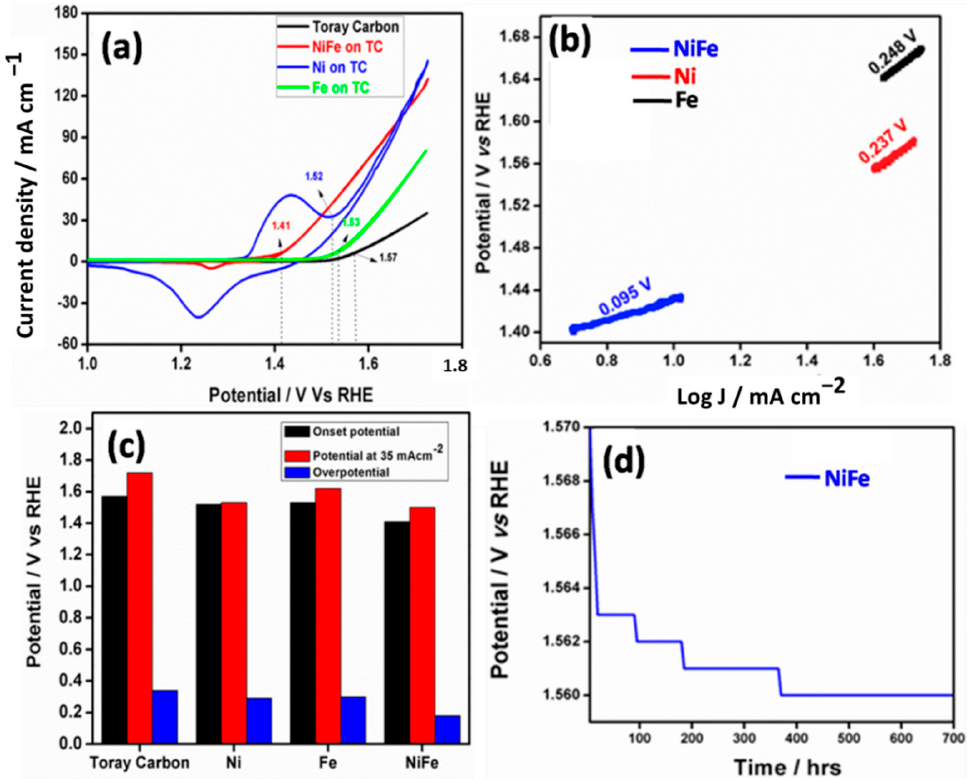
Figure 7. OER studies to evaluate performance of as-prepared samples. ( a ) LSV study of TC, Fe on TC, Ni on TC, and NiFe-LDH on TC tested in 1M KOH electrolyte solution with scan rate of 10 mV s − 1 . ( b ) Tafel slope values of Fe on TC, Ni on TC, and NiFe-LDH on TC. ( c ) Comparison plot of the onset potential, the onset potential at 35 mA cm − 2 , and the overpotential for TC, Fe on TC, Ni on TC, and NiFe-LDH on TC. ( d ) Stability test for NiFe-LDH on TC.